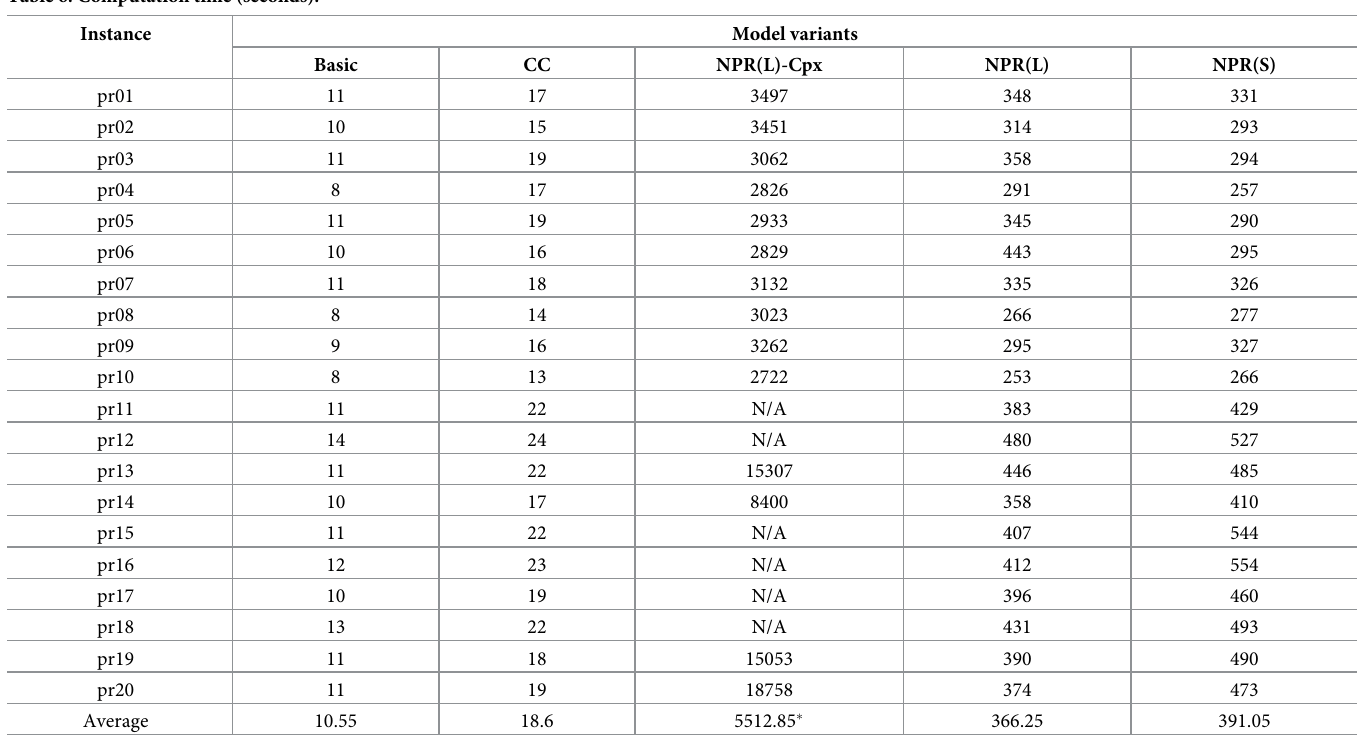
Table 6. Computation time